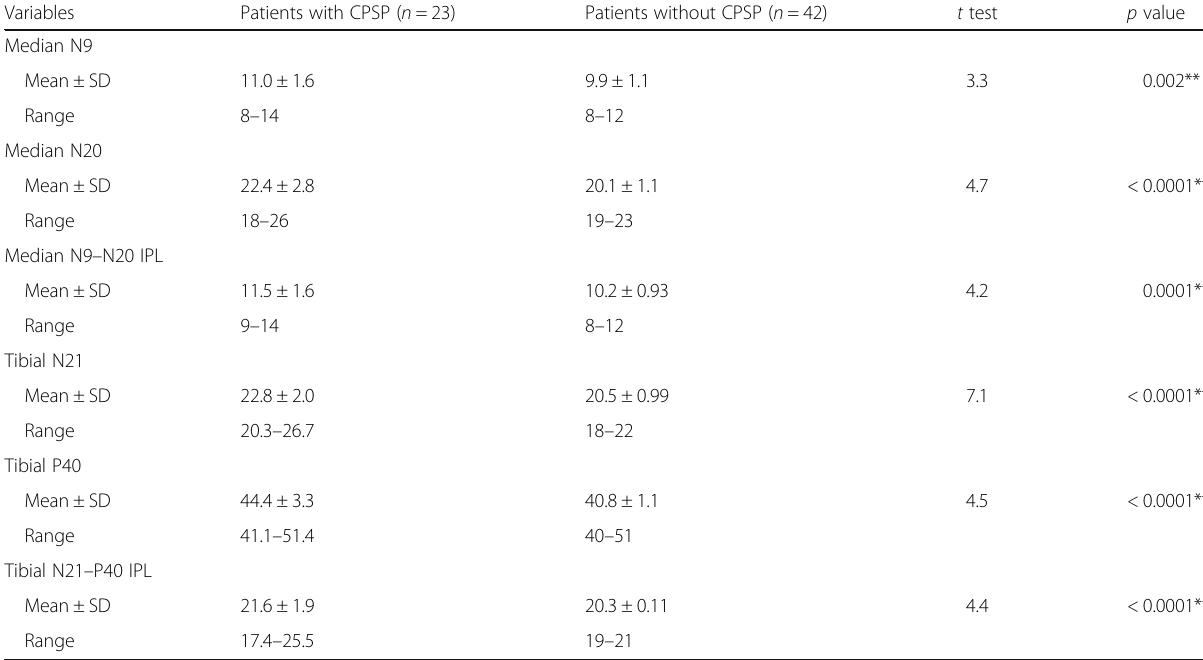
Table 3 SSEP; of median and tibial nerves Variables Patients with CPSP ( n = 23) Patients without CPSP ( n =